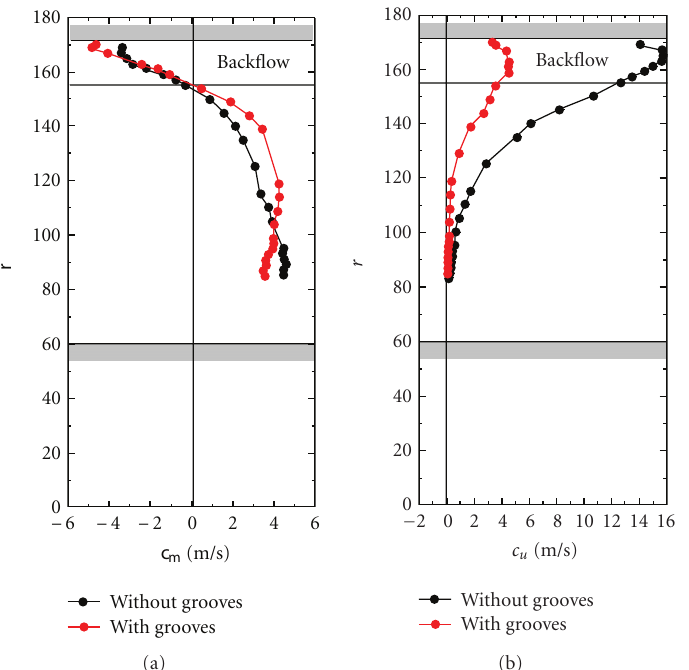
Figure 3: Axial and circumferential components of the time mean absolute velocities in front of the rotor in deep stall, Q/Q N = 0 . 48, NPSH A = 35 m, Kosyna et al. [8].